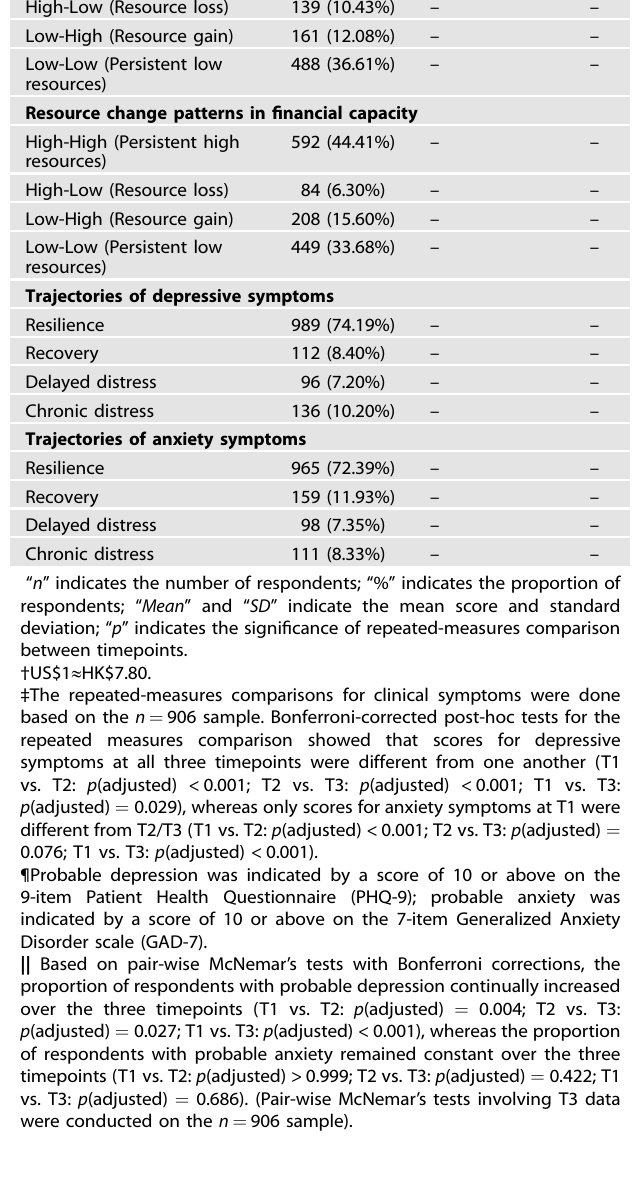
ery from chronic distress. Detailed statistical results are summar- ized in Table 3.